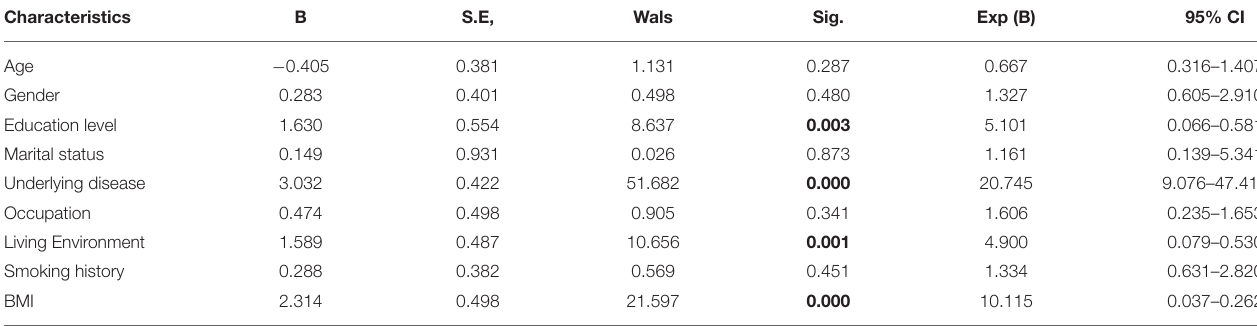
TABLE 5 | Logistic regression analysis of high-risk factors in patients with NTM lung disease. Characteristics